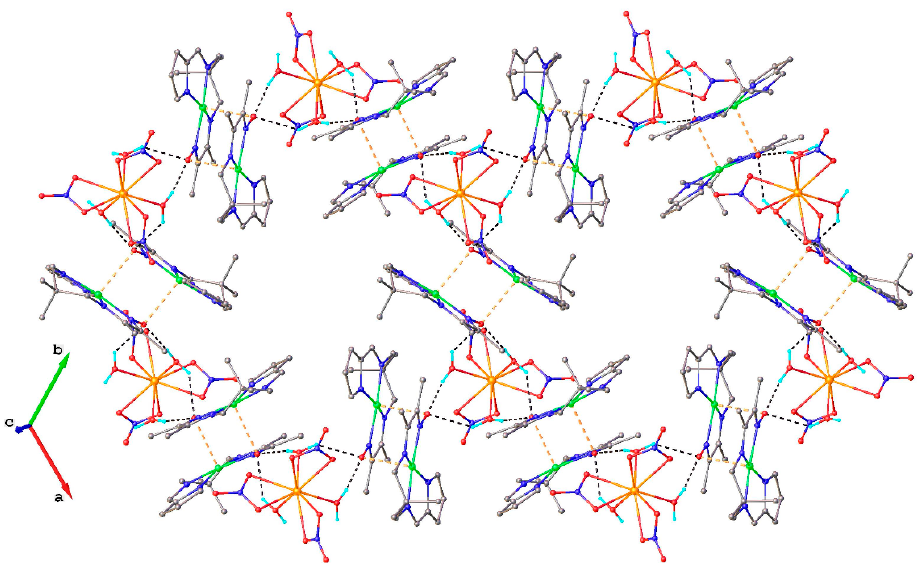
Figure 5. View of the two-dimensional network in the crystal structure 5 . H-bonds and the axial Cu–O1(1 − x , 1 − y , 1 − z ) bonds are shown in black and orange dashed lines, respectively.